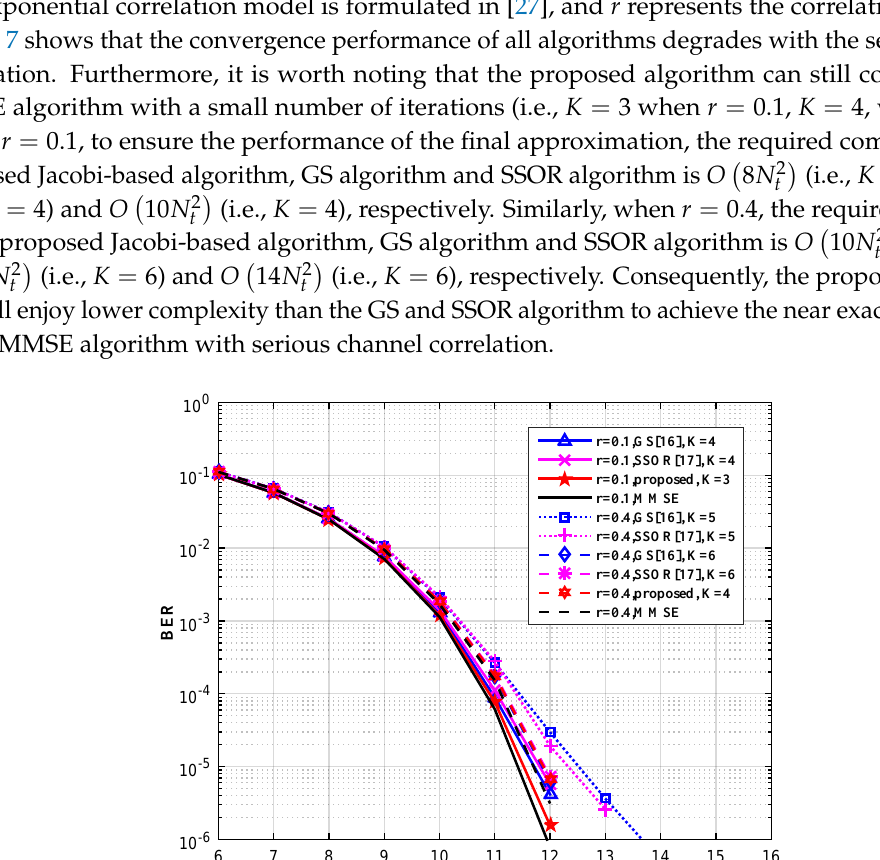
Figure 6. BER curves with the different number of users.